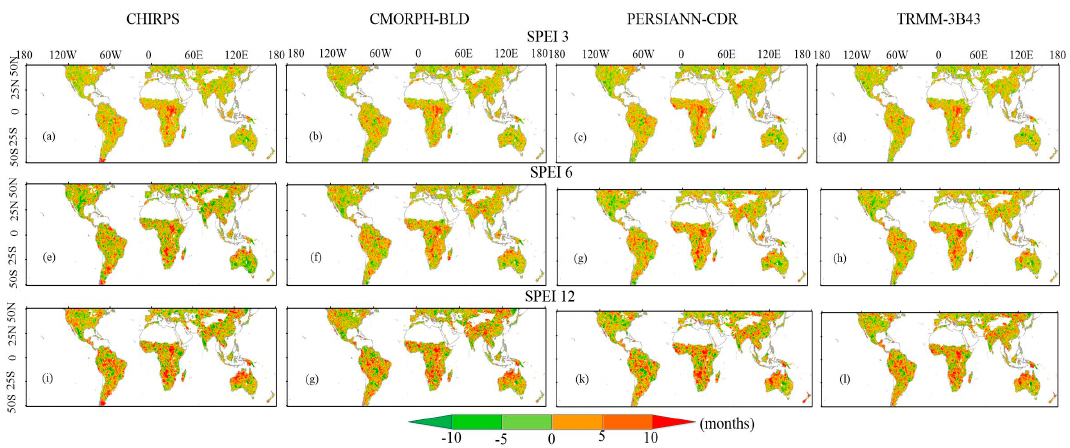
Figure 4. Spatial distributions of drought month’s numbers di ff erences calculated by every QPE product subtracting reference data between 2000 and 2016 ( a – i ).